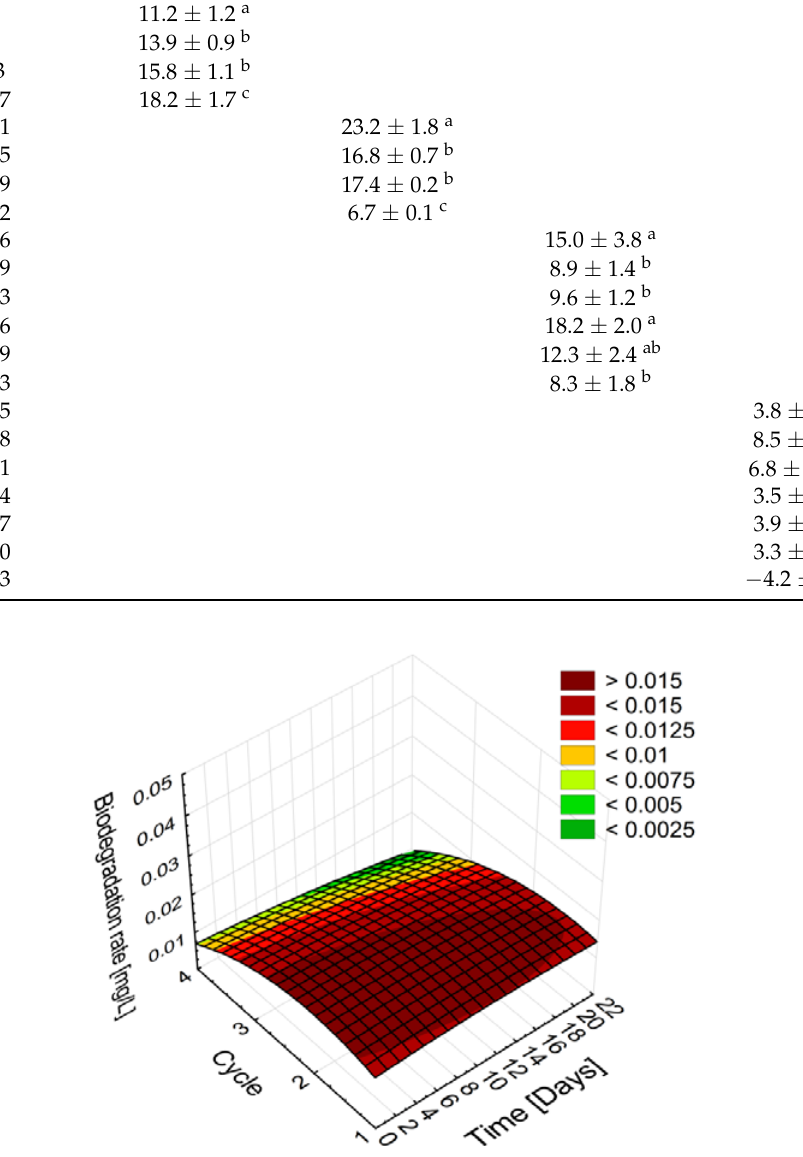
Figure 5. Naproxen (6 mg/L) biodegradation rate during subsequent cycles by immobilized on loofah sponges cells of Planococcus sp. S5 presented as patterns and the relationships among the time of incubation, cycle and biodegradation